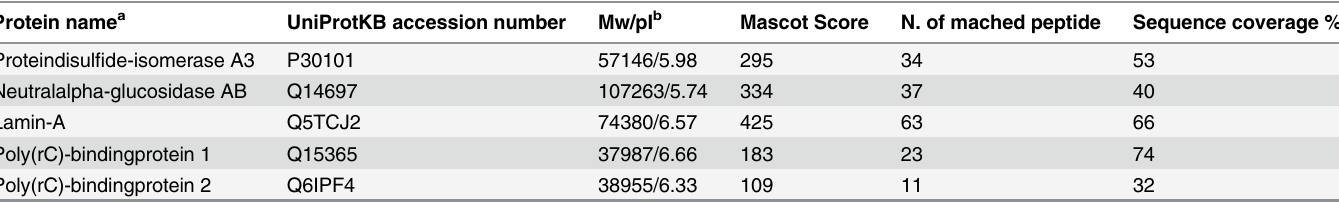
Table 2. MALDI ToF identification of down-regulated proteins in A375 melanoma cells treated with Rosmarinus officinalis extract. Protein name